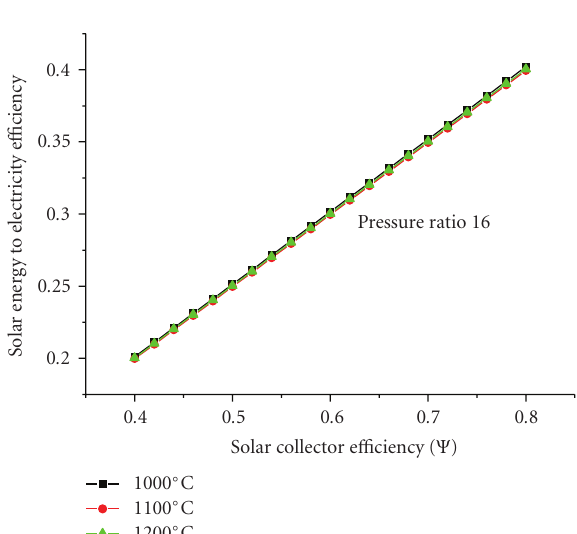
Figure 6: Solar energy to electricity e ffi ciency variation with solar collector e ffi